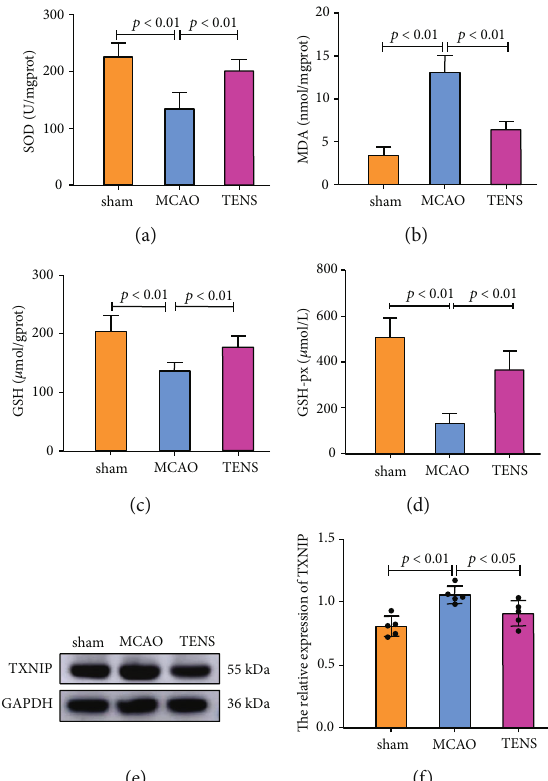
Figure 3: The e ff ect of TENS treatment on oxidative stress-related proteins. (a – d) Statistical analysis of the SOD, MDA, GSH, and GSH-px activities assessed by kits. (e) TXNIP expression was detected by western blot. (f) Statistical analysis showing the TXNIP expression in the ipsilateral hippocampus among three groups.